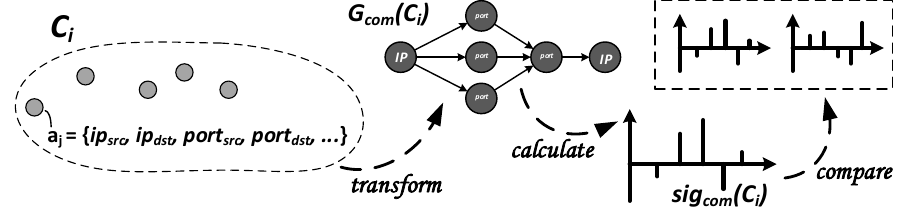
Figure 4. The generation and comparison process of the signature sig com with respect to